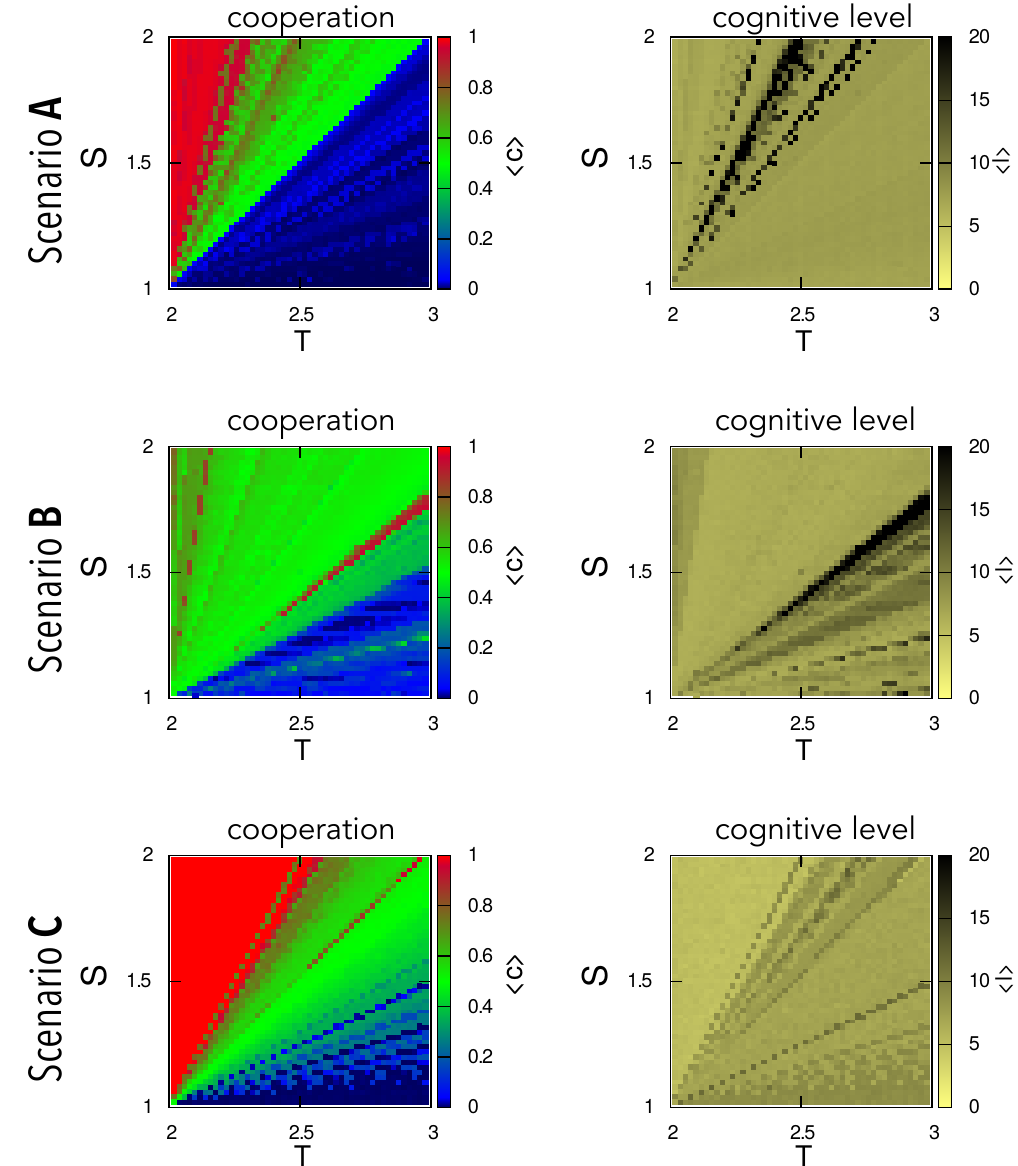
Figure 2. Simulation of the dynamics of the Snowdrift Game (SG). The figure shows in color code representation the averaged values of cooperation (left panels) and cognitive level (right panels) in the stationary state for the initial conditions specified in main text. Upper panels show the results for Scenario A, where agents assume a truncated Poisson distribution of cognitive levels in the population; middle panels show the results for Scenario B; and lower panels show the results for an assumed homogeneous distribution (Scenario C). Each point shows the result averaged over 100 Monte Carlo simulations. Parameter values are N = 10 3 , u = 0.45 and (for Scenario A) δ = 1 and v =